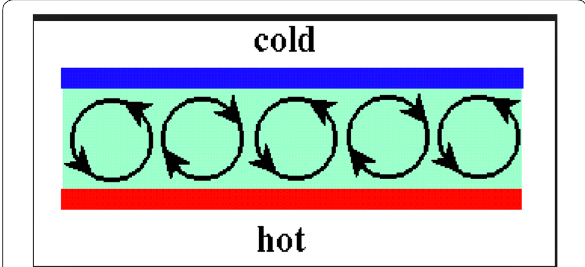
Fig. 1 A schematic representation of Rayleigh–Bénard